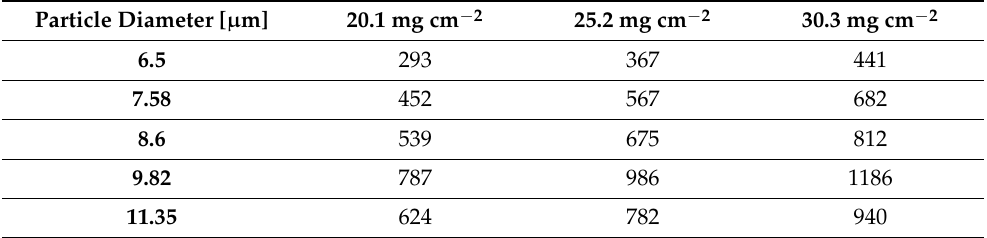
Table A1. Number of particles of each size fraction used for each areal